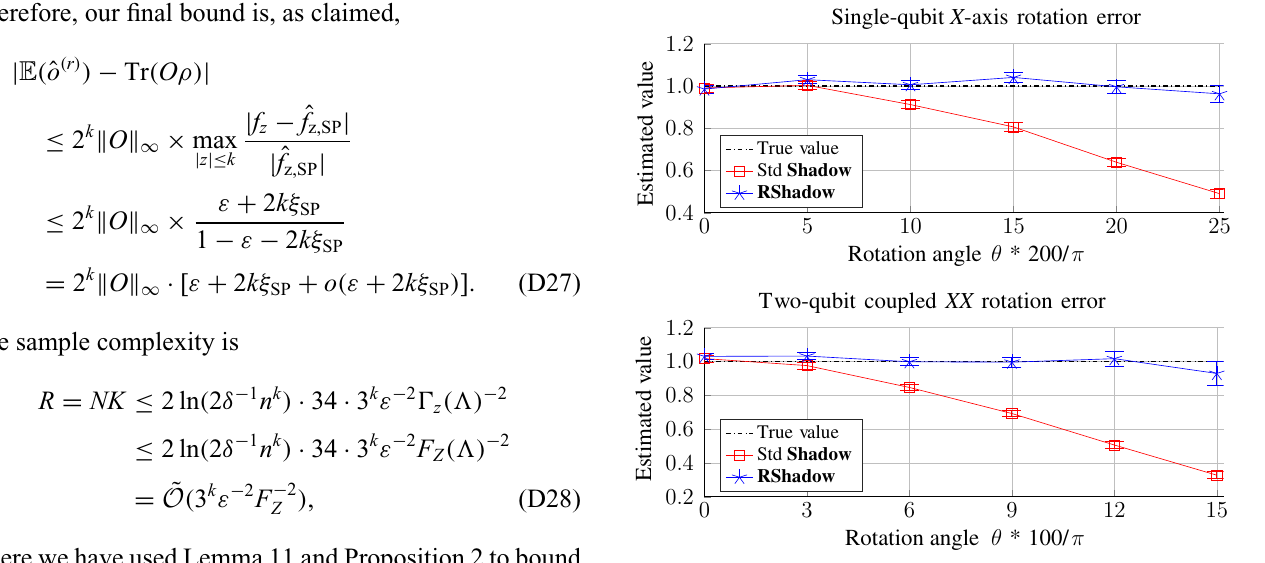
FIG. 8. Five-qubit GHZ two-point correlation function esti- mation under the coherent noise models, including single-qubit X -axis rotation and two-qubit XX -coupling noise.